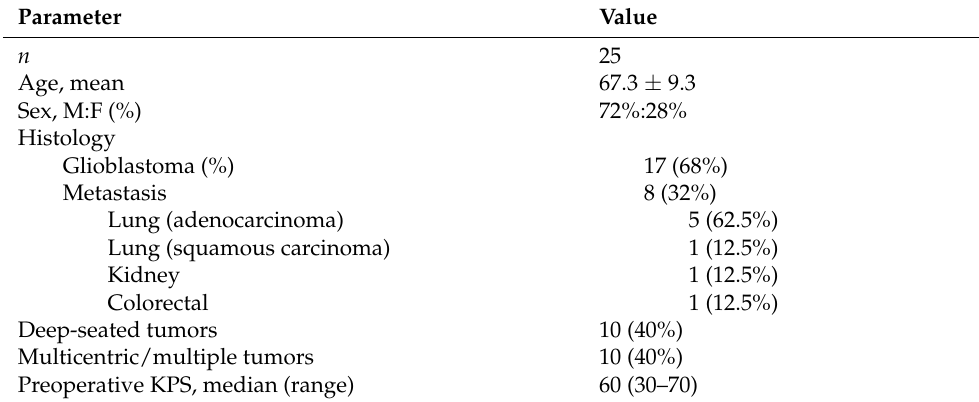
Figure 1. Study flowchart. Table 1. Demographics of enrolled patients.